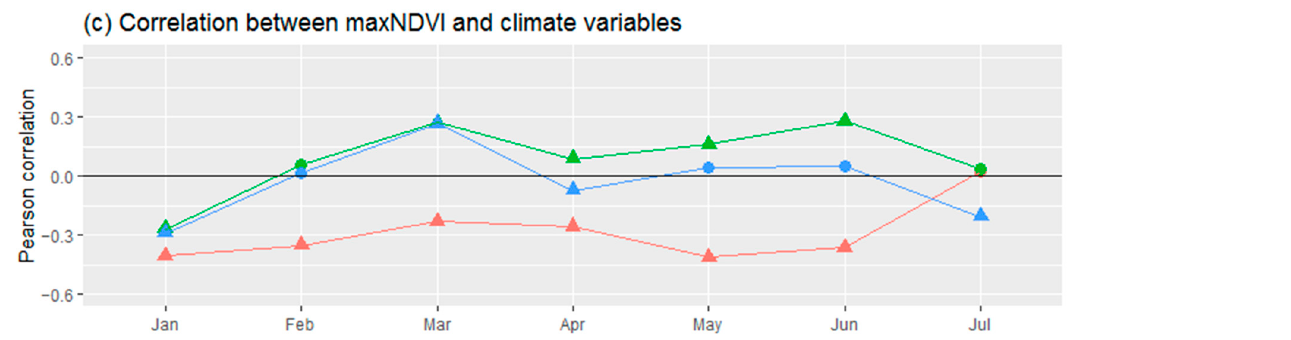
Figure 7. ( a ) Pearson correlation between winter wheat yield and monthly precipitation (P), minimum temperature (Tmin) and maximum temperature (Tmax) for the months from January to July); ( b ) Pearson correlation between aNDVI and monthly precipitation (P), minimum temperature (Tmin) and maximum temperature (Tmax) for the months from January to July; ( c ) Pearson correlation between maxNDVI and monthly precipitation (P), minimum temperature (Tmin) and maximum temperature (Tmax) for the months from January to July. The months from January to July are indicated by the first three letters of each month. Significant correlation values (i.e., p -value < 0.01) and non-significant correlation values (i.e., p -value > 0.01) are indicated with triangles and circles, respectively.